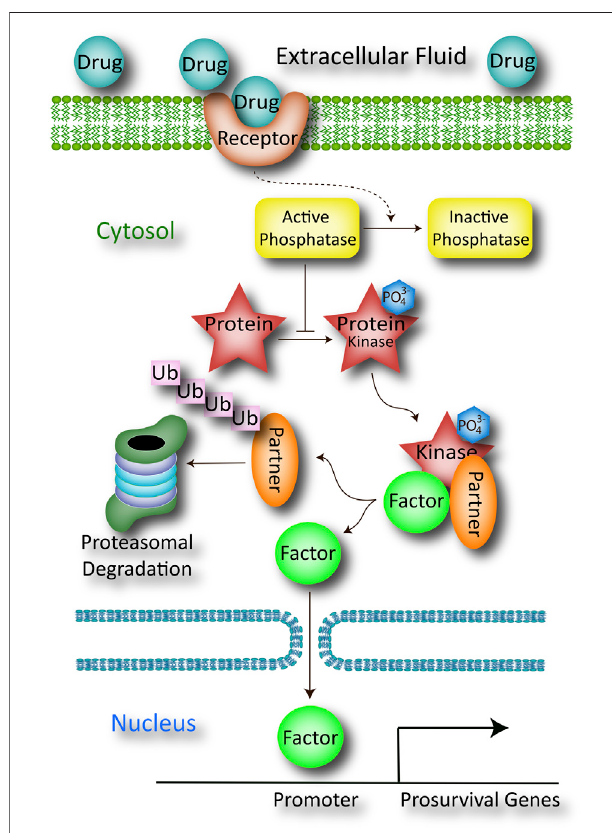
FIGURE1| Schematicofaworkinghypothesis drawnfromtheliterature or prior evidence collected using in silico computational modeling, in vitro cell culture work, ex vivo studies of organs or organ slices, in vivo studies in animals, or RNA sequencing and proteomics. The pharmaceutical drug candidate is believed to bind a plasma membrane-bound receptor ( e.g ., G-protein coupled receptor) that indirectly inactivates a cytosolic protein phosphatase through a series of G-protein mediated steps not shown here (dotted line). This inactivation step serves to increase the net phosphorylation state of the protein, shown as a red star with an attached PO 43- group. The phosphorylated protein serves as a kinase that promotes the release of a transcription factor from its inhibitory partner through a second phosphorylationevent.Thedetachedinhibitorypartnerisrapidlyubiquitinated and degraded by the proteasome, and its absence permits the translocation of transcription factor across the nuclear membrane. Once the transcription factor has entered the nucleus, it binds the promoters of multiple genes involved in cellular defense. The products of those prosurvival genes then battleapoptosistomitigatethetoxicsequelaeofthepreclinicaldiseasemodel.